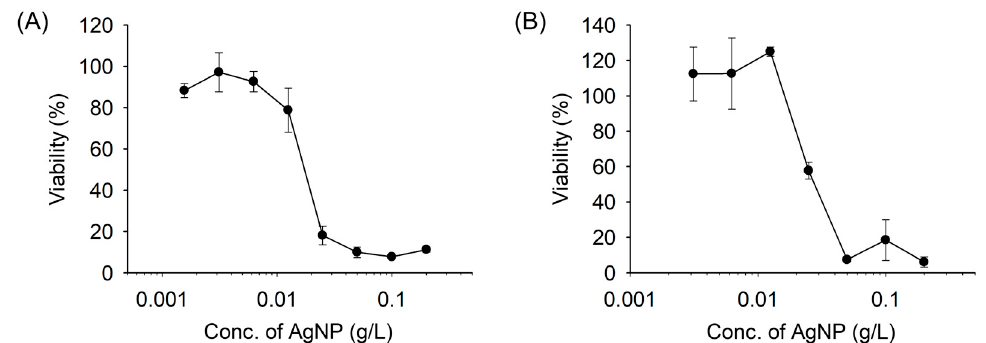
Figure 8. In vitro ( A ) 2D and ( B ) 3D cell viability assay of BMSCs incubated with AgNPs and AgNPs- incorporated hydrogels for 24 h ( n = 3). The value in the 3D cell viability assay was normalized by the blank hydrogel group.